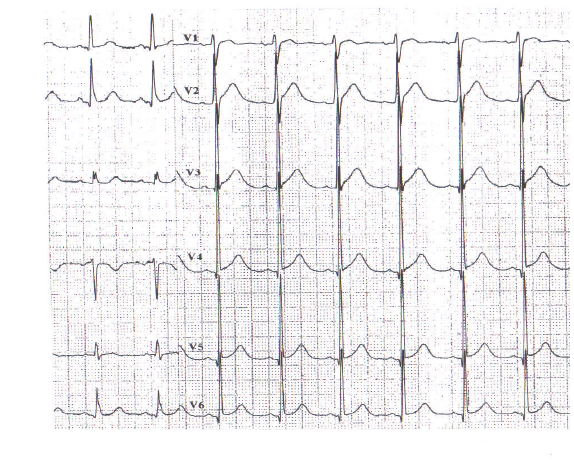
Figure 5: ECG record of 32 minutes after attack at 6:14 a.m. on August 4,